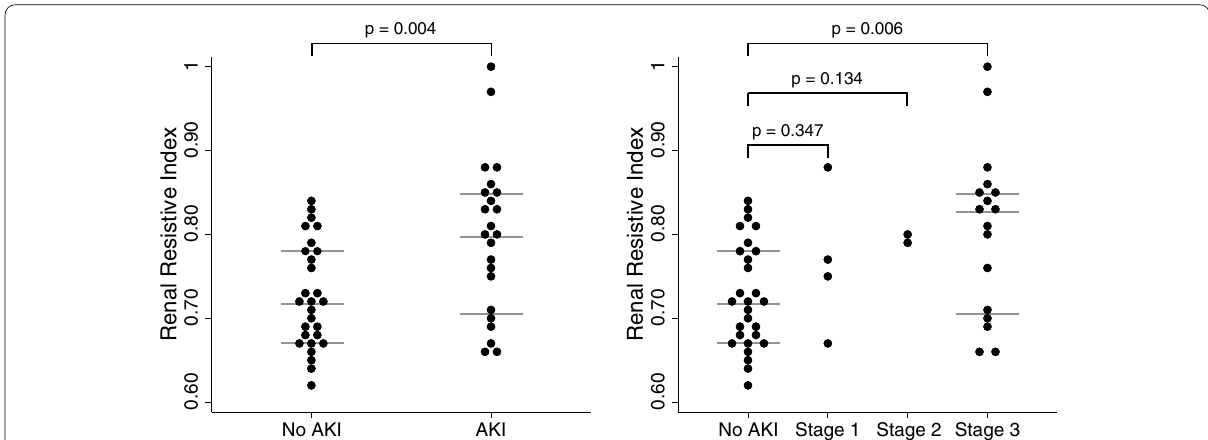
Fig. 2 Dot plot illustrating the association between renal resistive index and acute kidney injury (AKI) in patients with or without AKI (left) and patients with different stages of AKI (right). Each dot represents a patient. The horizontal lines represent the median, upper and lower quartiles